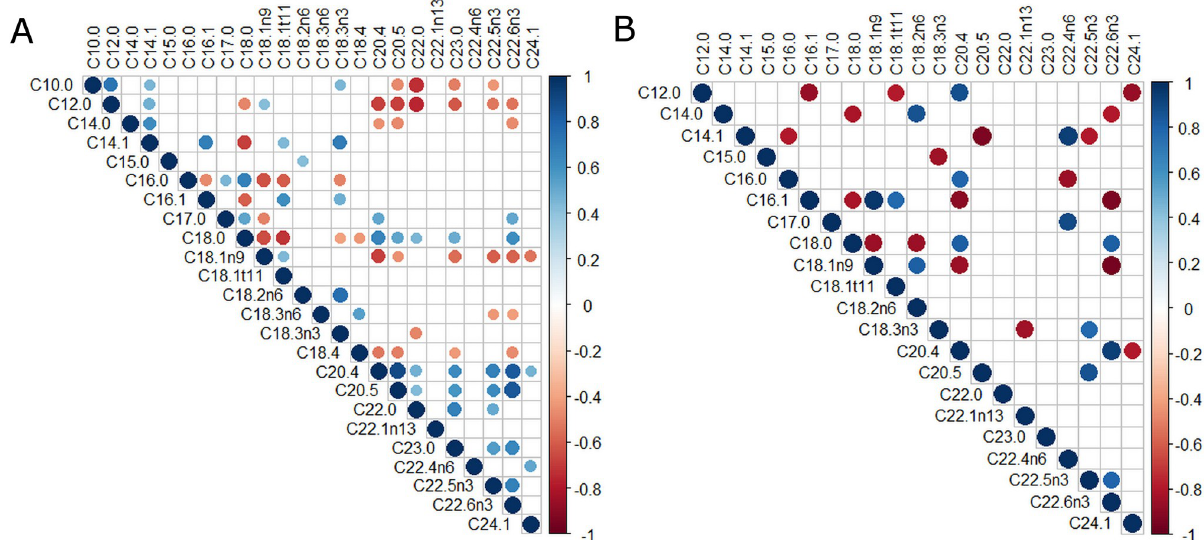
Fig 2. Correlations of FAs percentage in ATME. A. SCC grade 1+2. B. SCC grade 3. Red or blue dots on the correlogram, depending on the direction of the correlation, the dot size in the correlation matrix is proportional to the strength of the correlation.